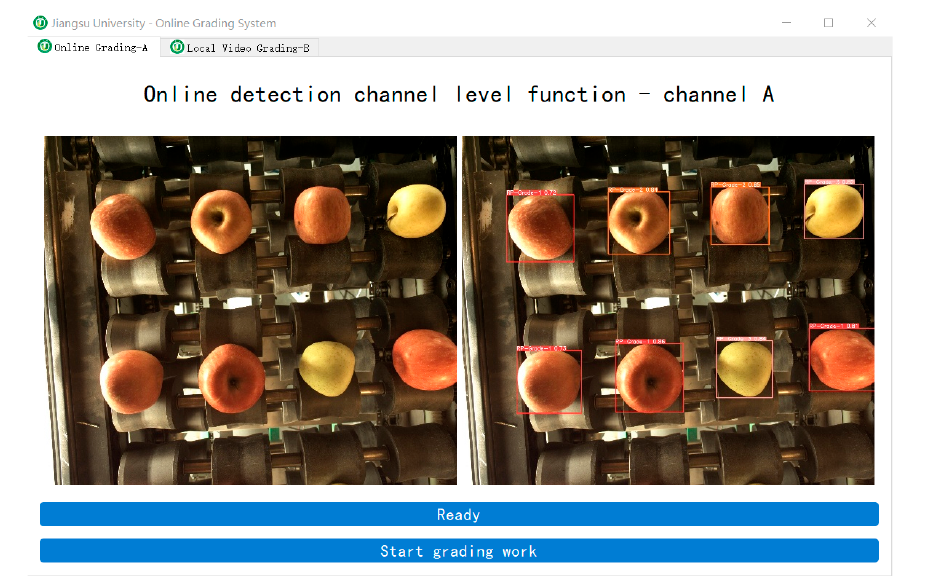
Figure 18. Apple auto-grading software. Table 4. Grading experimental